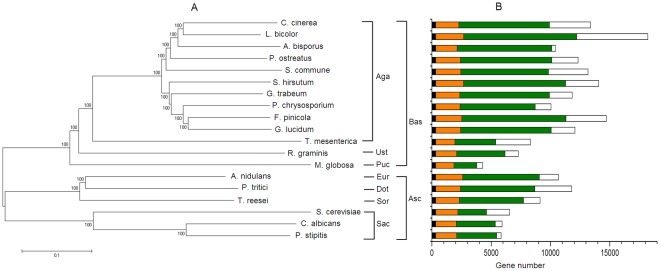
Phylogeny tree of 19 fungi and genes in their genomes.(A) The Neighbor Joining tree (NJ) was constructed with 1,000 bootstrap replications from a concatenated alignment of 323 single-copy proteins. (B) Bars represent a comparison of the gene content of all these species in the corresponding position in NJ tree. Bars are subdivided to indicate different types of homology relationships. Black: genes that are found only one copy in all these fungi (323 genes); Orange: genes that were in all species but maybe more copies in some species; Green: genes presenting in more than one fungus but not in all these fungi; White: species-specific genes with no detectable homologs in other species genes. Abbreviations: Aga, Agaricomycotina; Ust, Ustilaginomycotina; Puc, Pucciniomycotina; Eur, Eurotiomycetes; Dot, Dothideomycetes; Sor, Sordariomycetes; Sac, Saccharomycotina; Bas, Basidiomycota; Asc, Ascomycota.